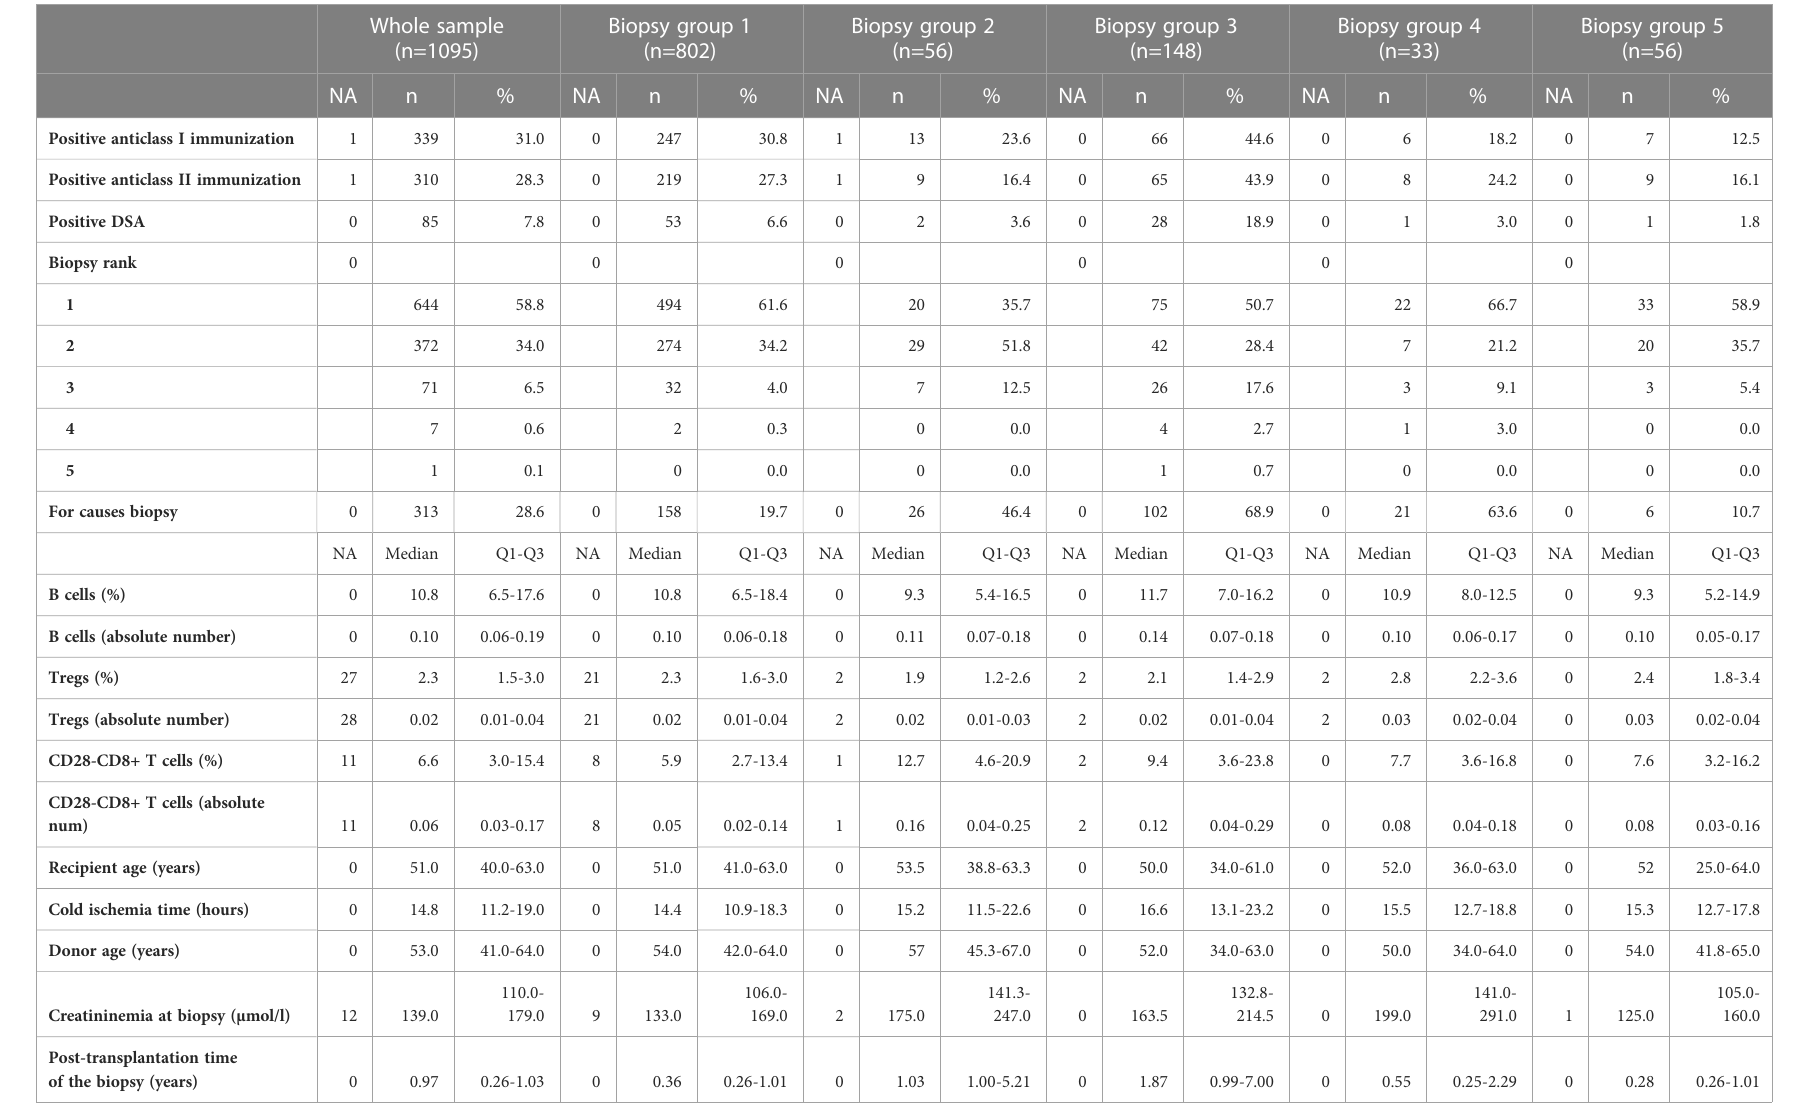
CMV, Cytomegalovirus; Recipient/Donor CMVserology de fi nition,0, negative donor and recipient; 1,negative donor and positive recipient; 2, positive donor andnegative recipient; 3, positive donor and recipient; DSA, donor-speci fi c antibodies; HLA, humanleukocyte antigens; Q, quartile; Q1, 25 th percentile; Q3, 75 th percentile; NA, not available (missing). %, percent of total lymphocytes; absolute number: thousand per µl. Biopsy group 1: normal/subnormal, group 2: interstitial fi brosis/tubular atrophy (IFTA) grade 2 or 3, group 3: ABMR, group 4, TCMR; group 5, borderline